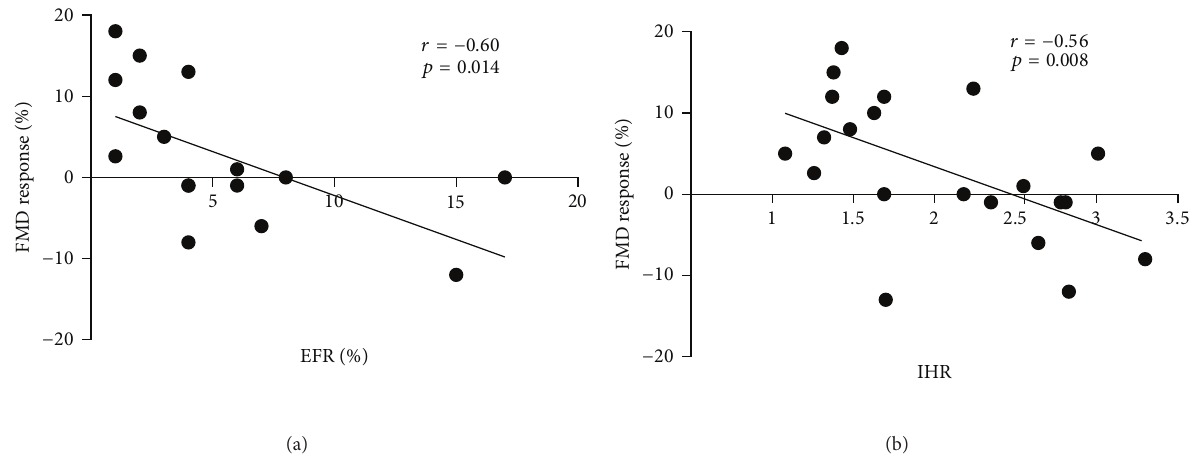
Figure 1: Negative correlation of flow-mediated dilation (FMD) response with Framingham risk score (a) and with baseline reactive hyperemia index